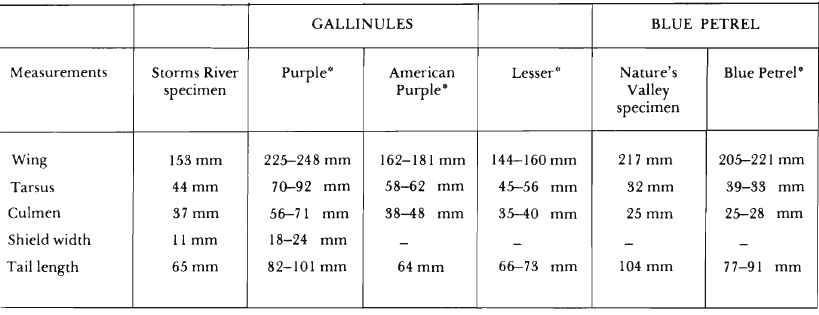
Comparative measurements of gallinules and blue